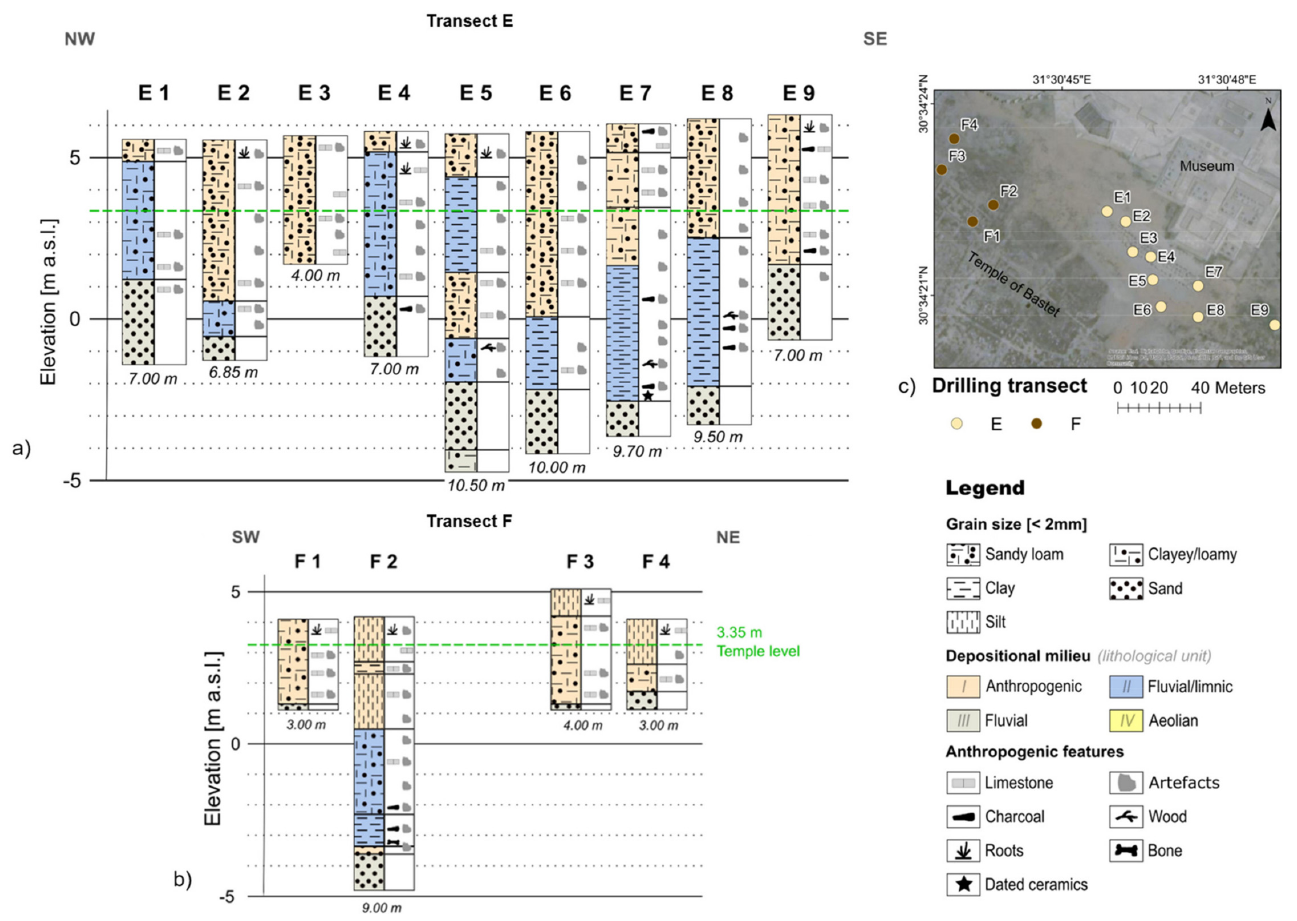
Figure 5. Drilling locations ( c ) and generalized results of drilling transects E–F in the north of the Temple of Bastet ( a , b ). The dashed green line marks the floor level of the Temple of Bastet in the 1st millennium BCE (3.35 m